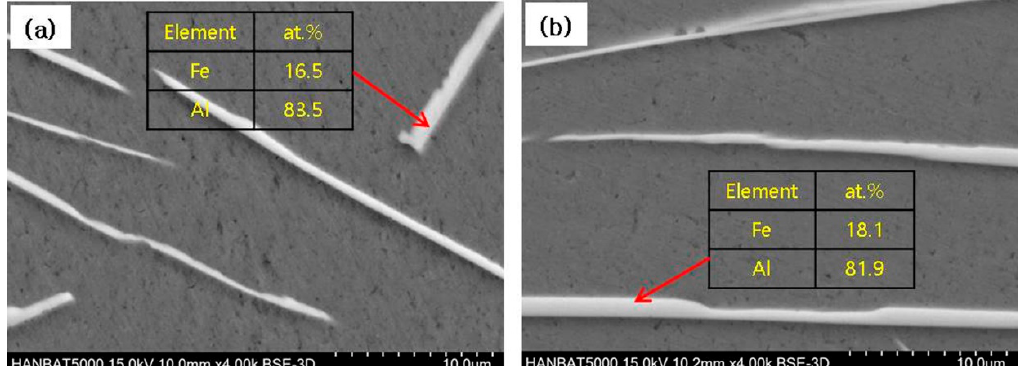
Figure 3. SEM micrographs and EDS line profile from the cast iron/liquid aluminum interface isothermally heated at 720 °C for different times: ( a ) 1 min and ( b ) 5 min.